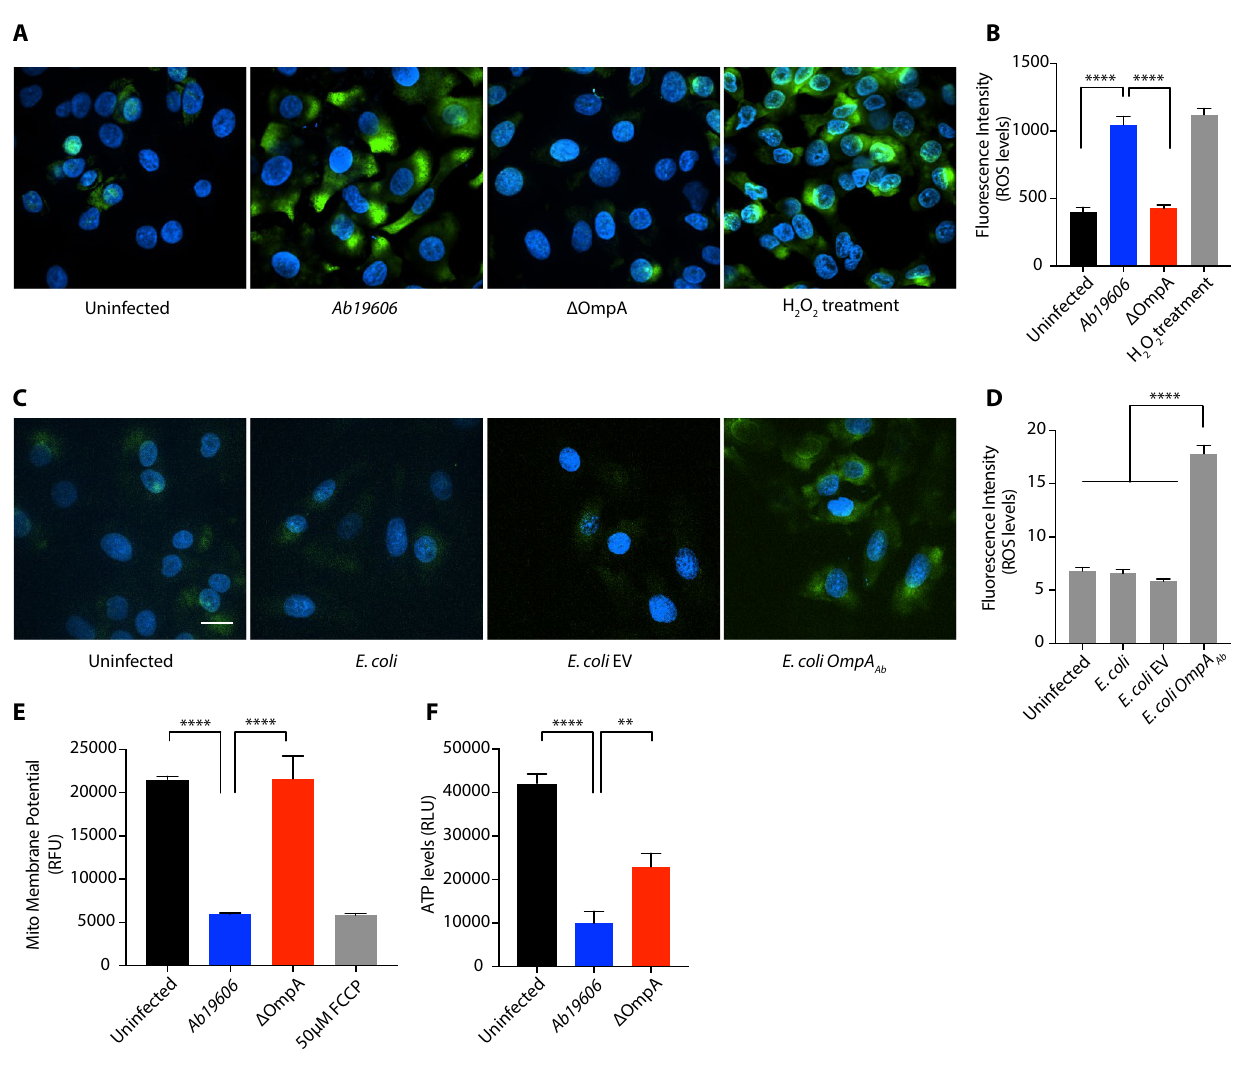
Figure 4. A. baumannii infection perturbs mitochondrial physiology in an OmpA Ab dependent manner. ( A ) A549 cells were infected with the indicated bacteria for 6 h at MOI 50. The cells were treated with the CellROX reagent to examine ROS (green) and DAPI to label nuclei (blue). 30% (v/v) H 2 O 2 treatment used at a final concentration of (1:1000) for 1 h at 37 °C served as positive control. Scale bar represents 20 µm. ( B ) The bar graph represents the quantification of ROS levels in A549 cells after the indicated infection/treatment. The experiment was done in triplicates, n = 90–103 cells. Error bars represent standard deviation. One-way ANOVA with Tukey’s multiple comparisons test **** p ≤ 0.0001. ( C ) A549 cells were infected with the indicated bacteria for 6 h at MOI 50. The cells were treated with the CellROX reagent to examine ROS (green) and DAPI to label nuclei (blue). Scale bar represents 20 µm. ( D ) The bar graph represents the quantification of ROS levels in A549 cells after the indicated infection. The experiment was done in triplicates, n = 72–85 cells. Error bars represent standard deviation. One-way ANOVA with Tukey’s multiple comparisons test **** p ≤ 0.0001. ( E ) TMRE